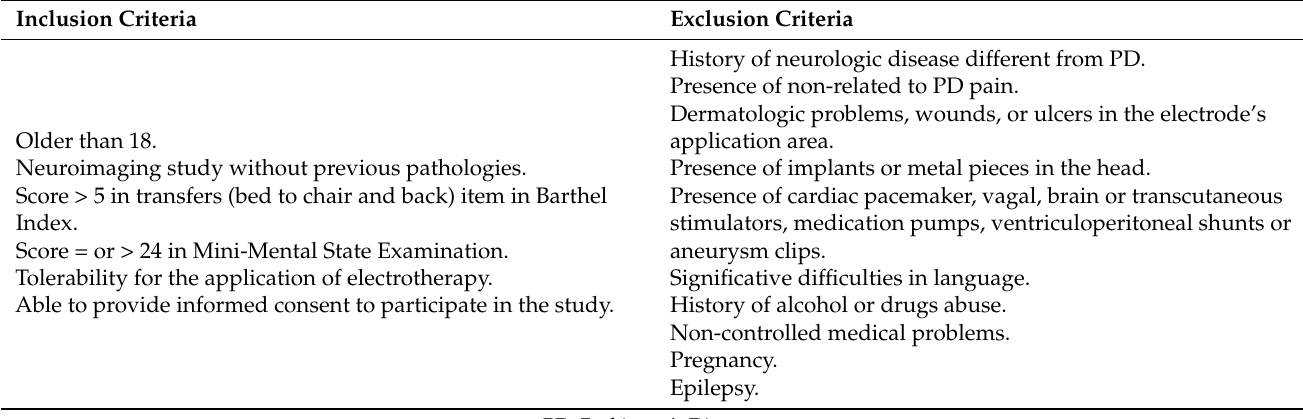
Table 1. Additional inclusion and exclusion criteria for the transcranial direct current stimulation (tDCS)-based Study. Inclusion Criteria Exclusion Criteria